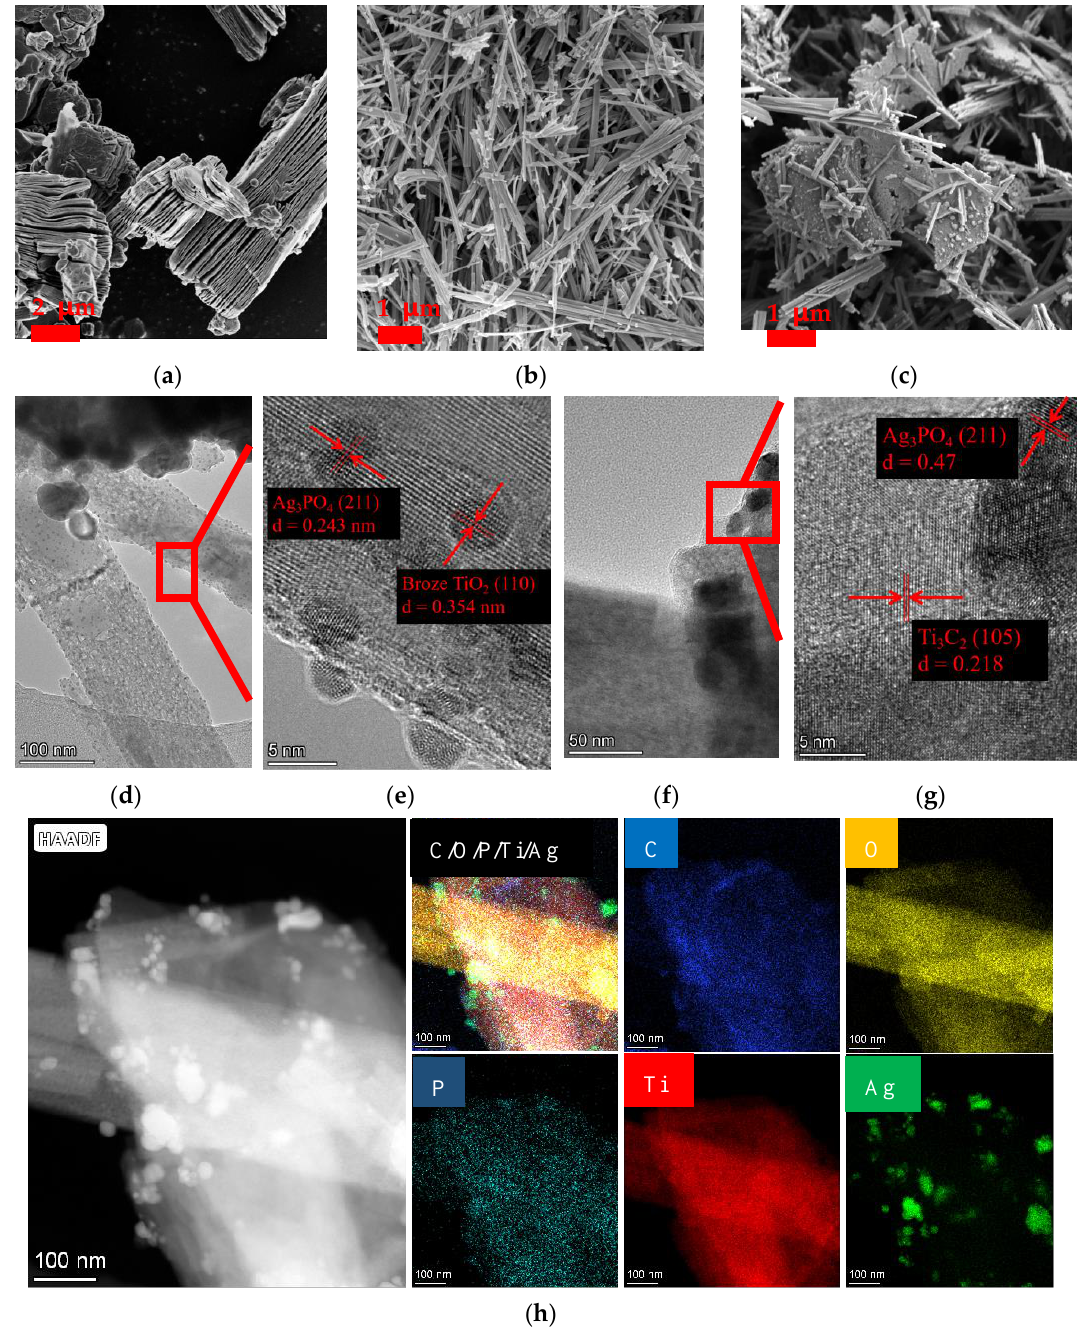
Figure 2. ( a ) SEM of Ti 3 C 2 MXene; ( b ) SEM of TiO 2 (B); ( c ) SEM of TiO 2 (B)/20%Ti 3 C 2 MXene/Ag 3 PO 4 ; ( d , f ) TEM of TiO 2 (B)/20%Ti 3 C 2 MXene/Ag 3 PO 4 ; ( e , g ) HRTEM of TiO 2 (B)/20%Ti 3 C 2 MXene/Ag 3 PO 4 ; ( h ) mapping and HAADF (high angle annular dark field image) of samples.